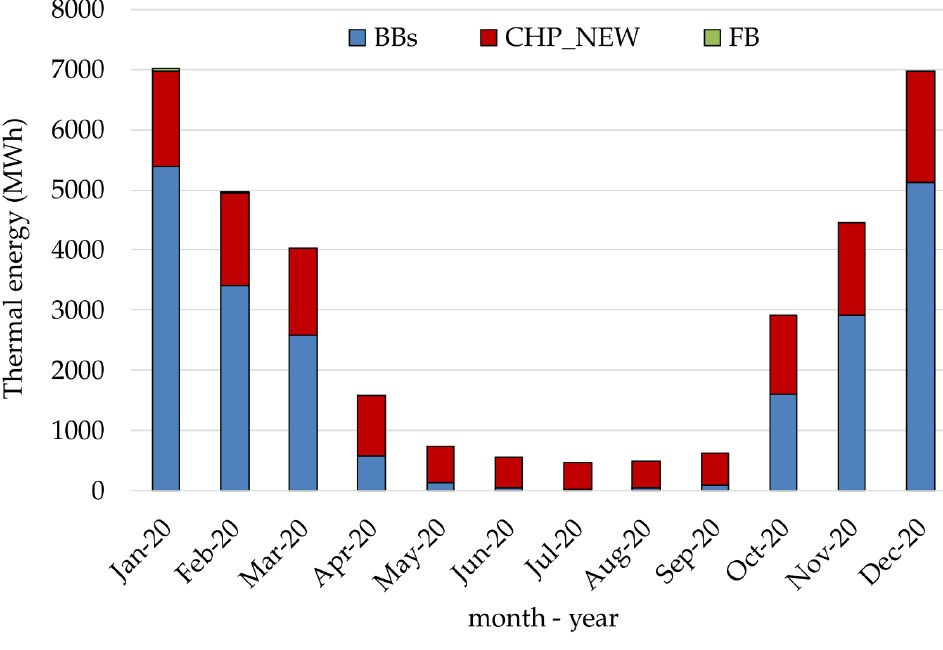
Figure 9. Contribution of the different energy conversion systems serving the DHN in the REC configuration (SC#_PV500). Table 8. Energy conversion systems (SC#1) able to meet the electricity demand required by the REC of Tirano.